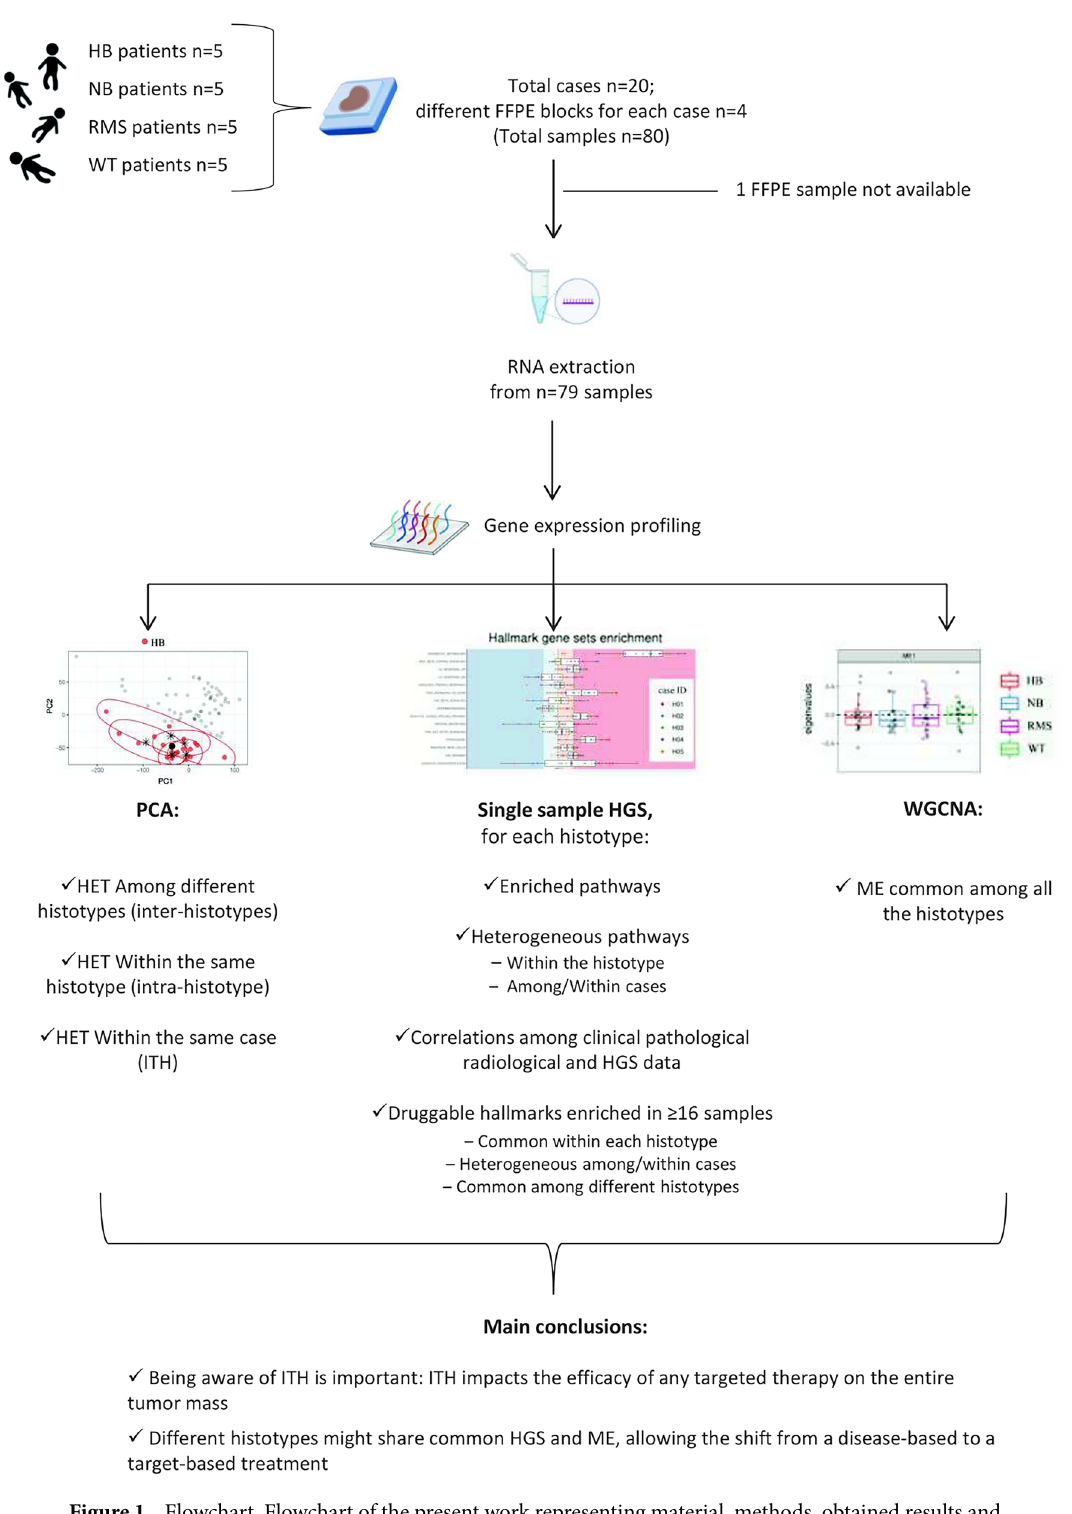
Figure 1. Flowchart. Flowchart of the present work representing material, methods, obtained results and conclusions. WT: Wilms Tumor; NB: neuroblastoma; HB: hepatoblastoma; RMS: rhabdomyosarcoma; n: number; FFPE: formalin-fixed, paraffin-embedded; PCA: Principal Component Analysis; HGS: Hallmark Gene Sets; WGCNA: Weighted gene co-expression network analysis; HET: heterogeneity; ITH: intra-tumor heterogeneity; ME: module eigengenes. The figure was created with with https:// BioRe nder.